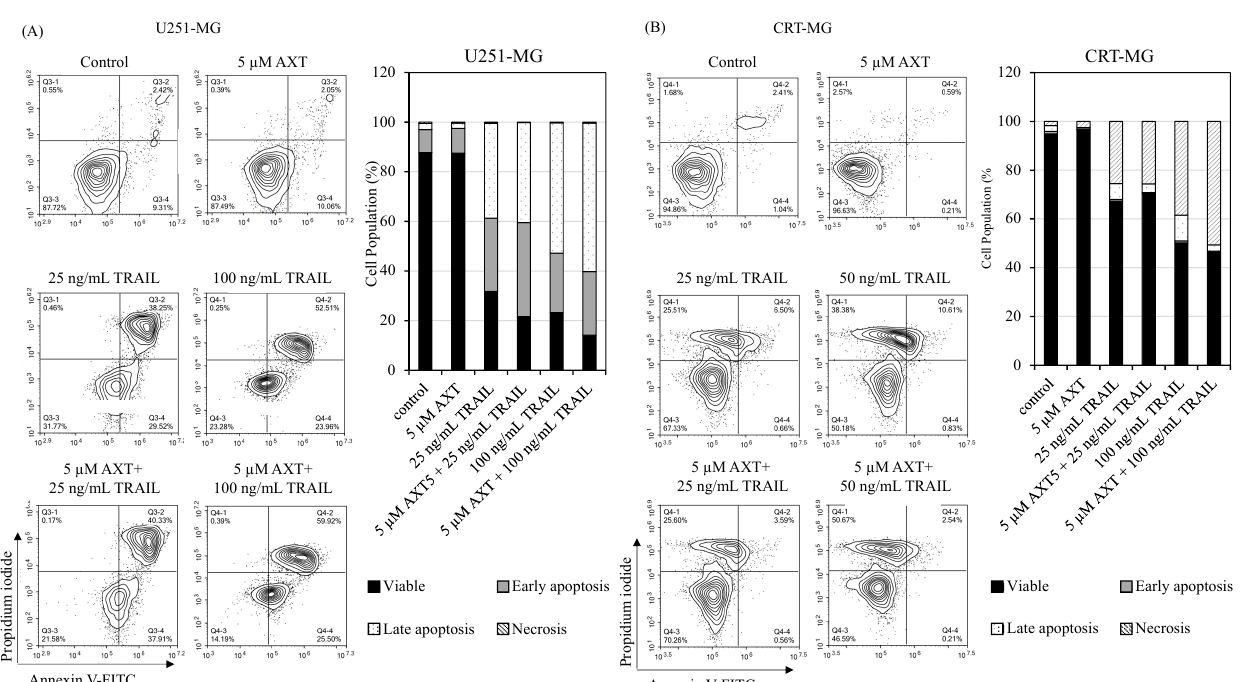
Figure 3. Pretreatment of AXT sensitizes U251-MG cells to TRAIL treatment by increasing apoptotic cells population. Sensitization was not observed in CRT-MG. ( A ) U251-MG cells and ( B ) CRT-MG cells were plated in 6-well plates and treated with 5 µ M AXT or 0.1% DMSO as pretreatment for 3 h prior to TRAIL 0, 25, or 50 ng/mL for 16 h. A total of 10,000 cells were analyzed per sample, and cell populations were divided based on staining as Annexin V − /PI − (Viable), Annexin V + /PI − (Early apoptosis), Annexin V + /PI + (Late apoptosis), and Annexin V − /PI + (Necrosis). Percentages of population are shown as graphs on the right of each cell